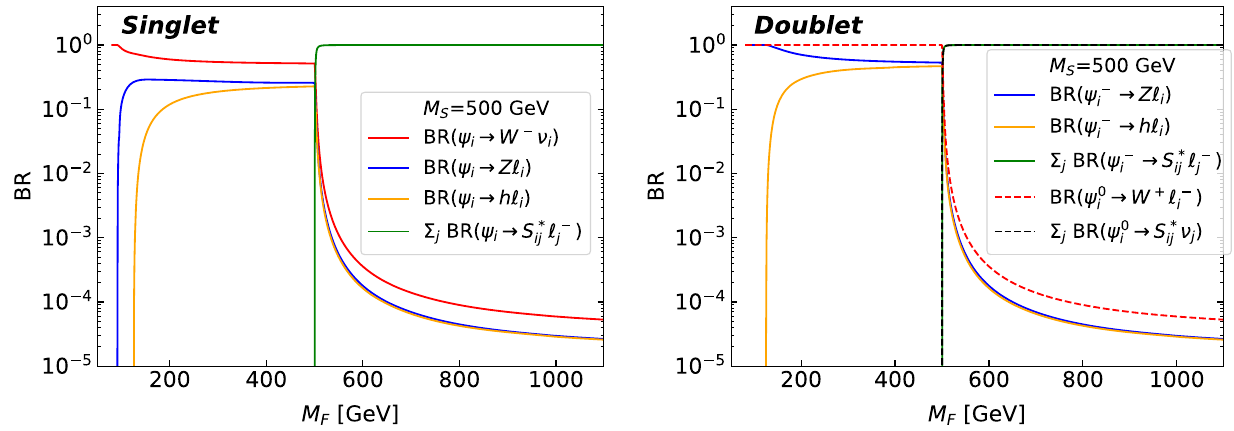
Fig. 2 Cross sections for ψ i pair production (top) and single production (bottom) at singlet model (left) and the doublet model (right) for M S = 500 GeV and the procedure described in (7)